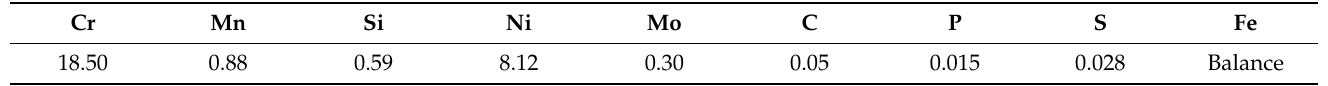
Table 1. Composition of